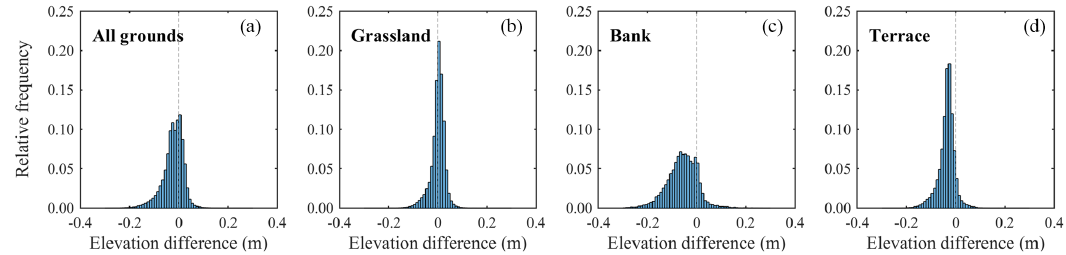
Figure 8. Comparison of elevation differences between SfM and ALS for distinct surface types.